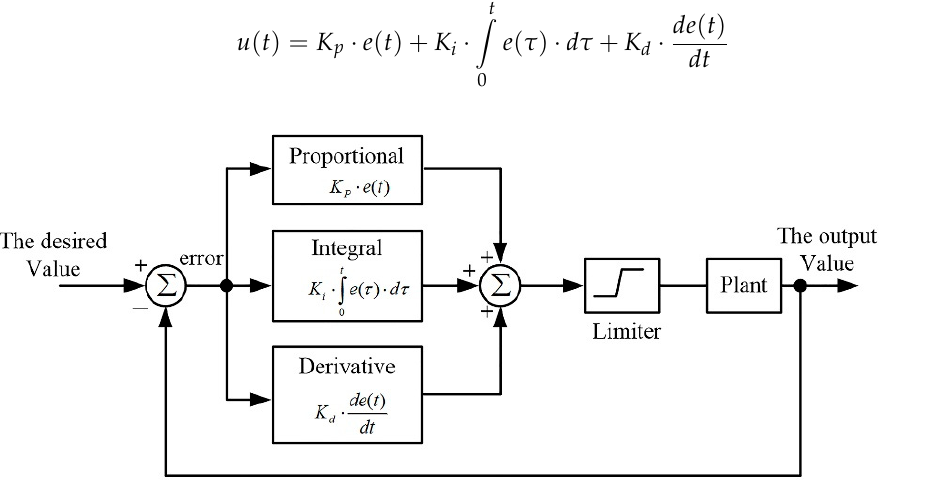
Figure 6. The PID controller of the AMCS.